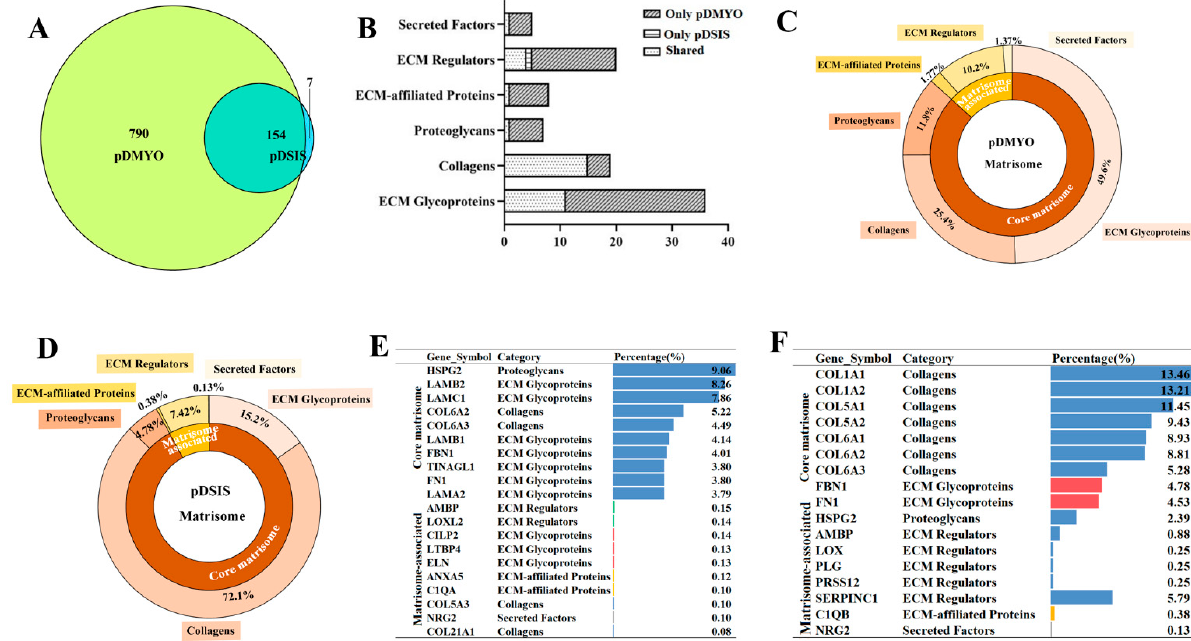
Figure 4. Proteomic analysis of pDMYO- and pDSIS-gels ( A ) Venn diagram of total proteins in pDMYO- and pDSIS-gels. ( B ) The common and unique matrisome proteins in pDMYO- and pDSIS-gels. ( C ) Types and proportion of matrisome proteins in pDMYO-gel. ( D ) Types and proportion of matrisome proteins in pDSIS-gel. ( E ) Top 10 matrisome proteins in pDMYO-gel. ( F ) Top 10 matrisome proteins in pDSIS-gel.